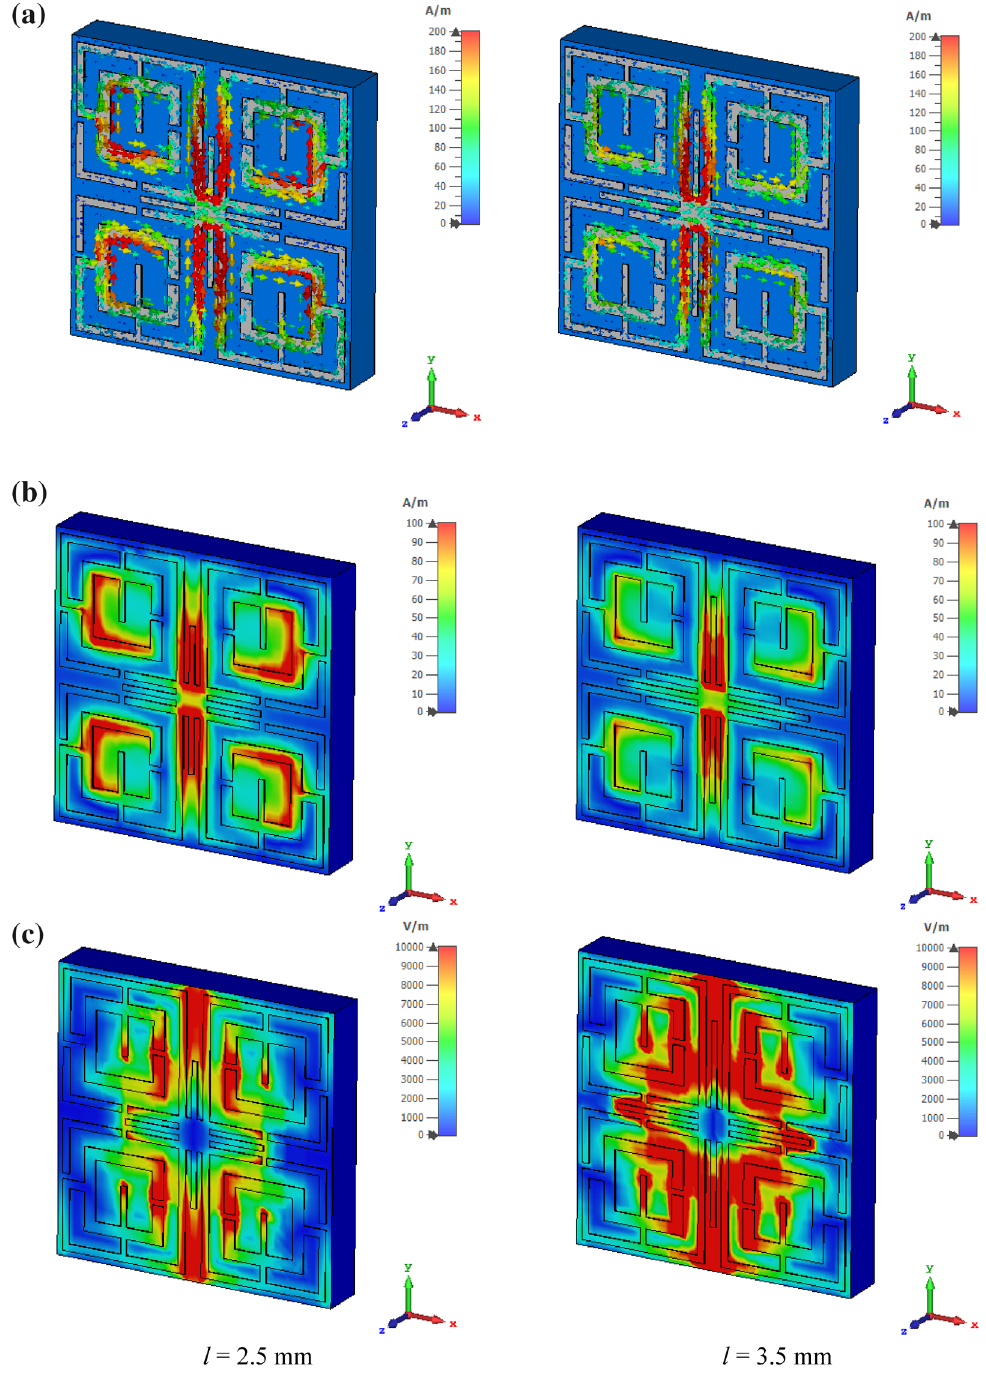
Figure 8. Analysis of EM wave interaction at 11.5 GHz for different length of tuning metallic stubs: ( a ) surface current ( b ) magnetic field ( c ) electric field (CST STUDIO SUITE 2019, https:// www. 3ds. com/ produ cts- servi ces/ simul ia/ produ cts/ cst- studio- suite) 42